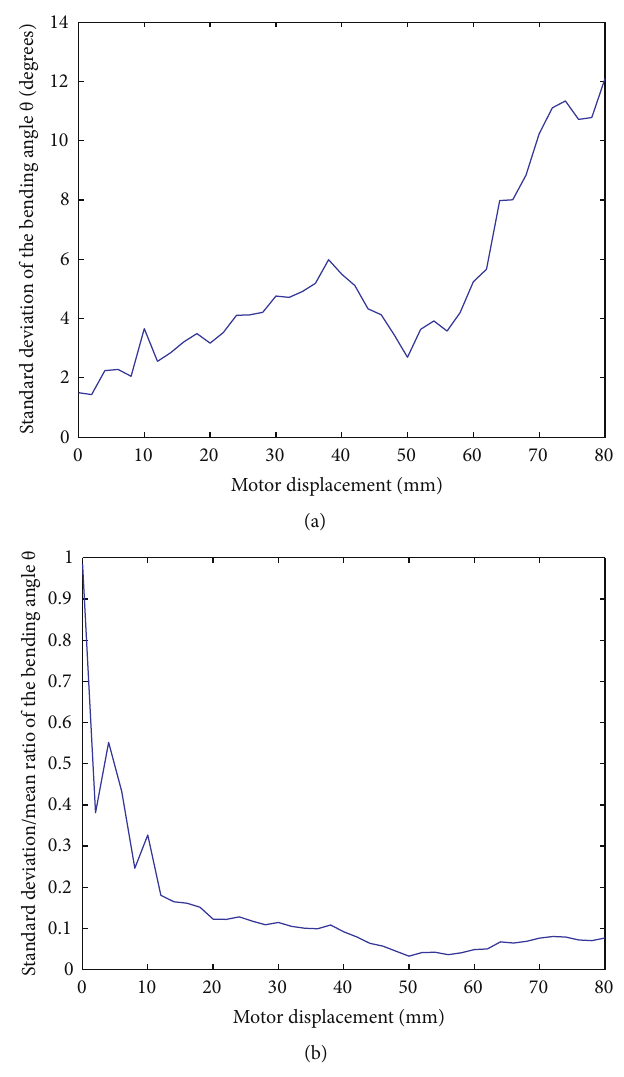
Figure 14: Finger ’ s total fl exing angle of all